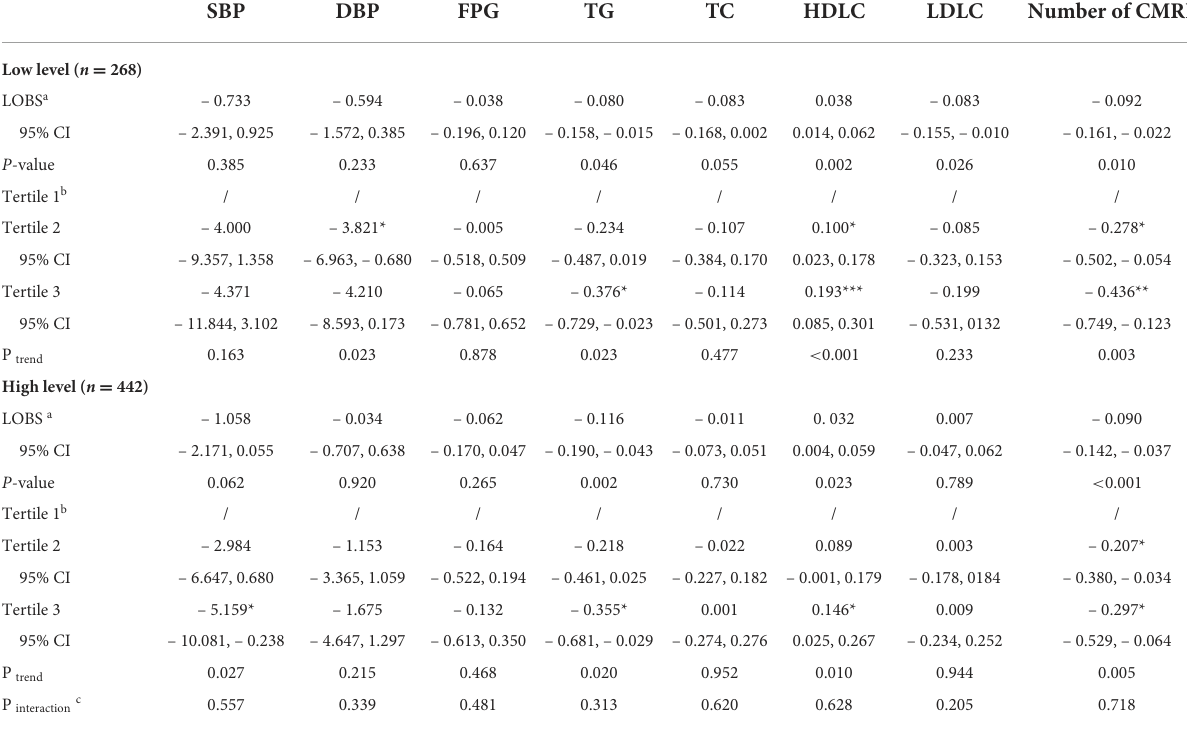
TABLE 6-1 Associations of the lifestyle-based oxidative balance score with the number of cardiometabolic risk factors and cardiometabolic biomarkers by socio-economic degree using linear